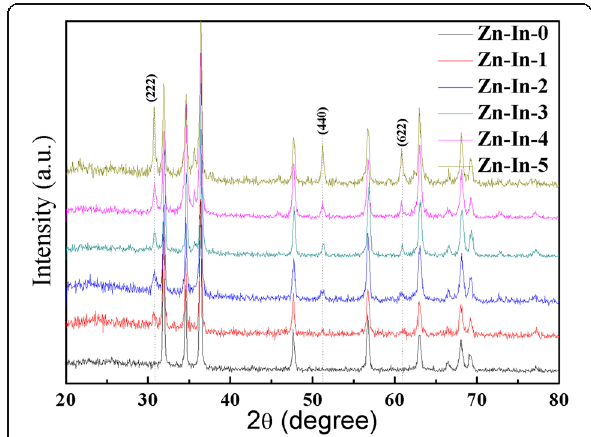
Fig. 2 XRD patterns of ZnO/In 2 O 3 composites with different